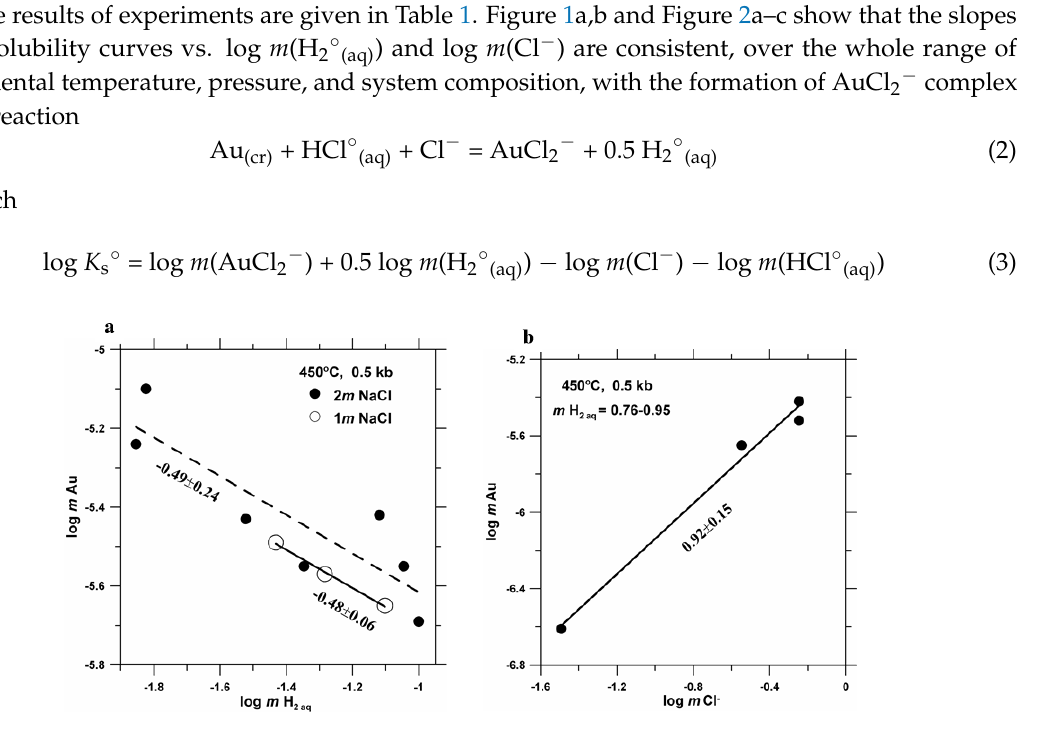
Figure 1. The concentration of Au ( a ) as a function of H 2 ° (aq) concentration at constant fluid salinities, and ( b ) as a function of Cl − concentration at constant dissolved hydrogen concentration. The slopes of the solubility curves are indicated in the diagrams. Experiments were performed with hydrogen added to the system (reduced conditions).